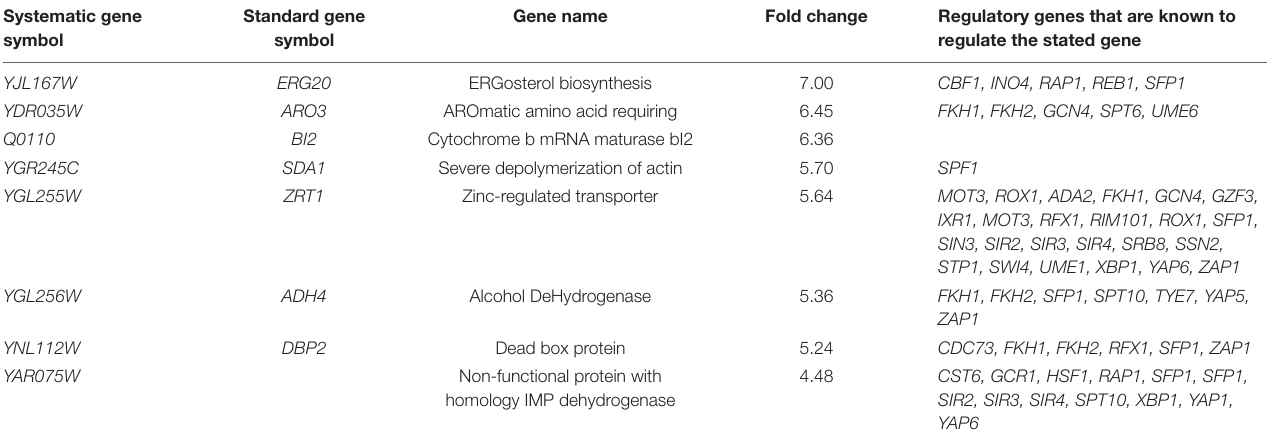
TABLE 3 | Genes that were down-regulated by at least fivefold in